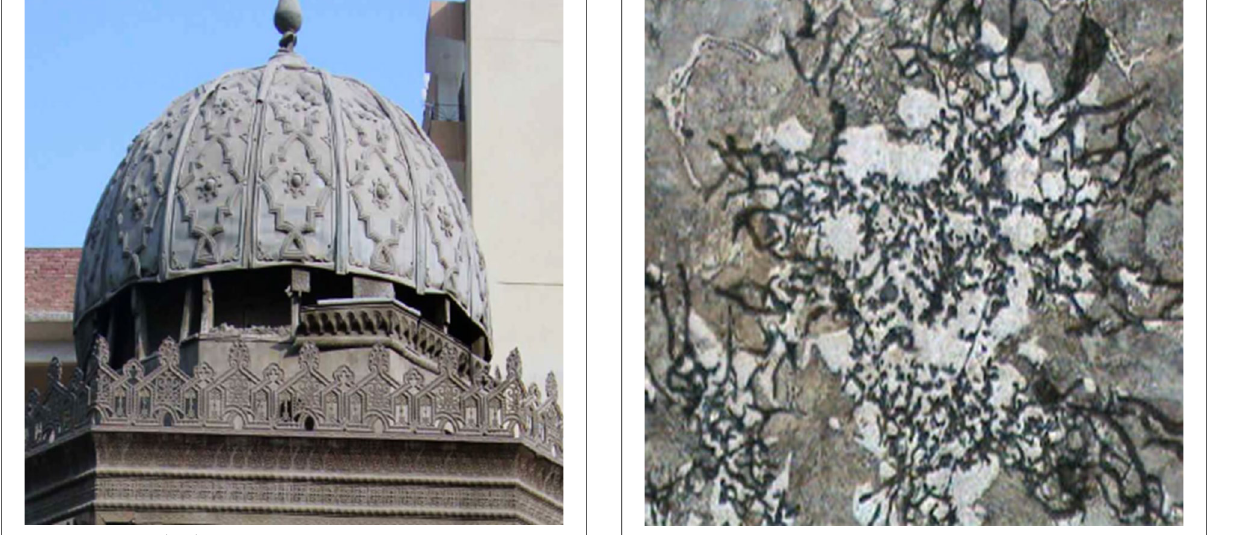
Fig. 6 Micrograph of a metallurgical structure consisting of ferrite (light constituent), pearlite (gray constituent), and graphite flakes (dark constituent). Etched in 5% Nital, ×